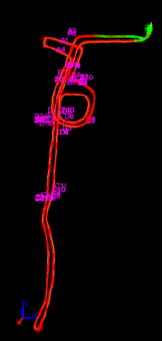
Figure 15: The track of DG verification of control point